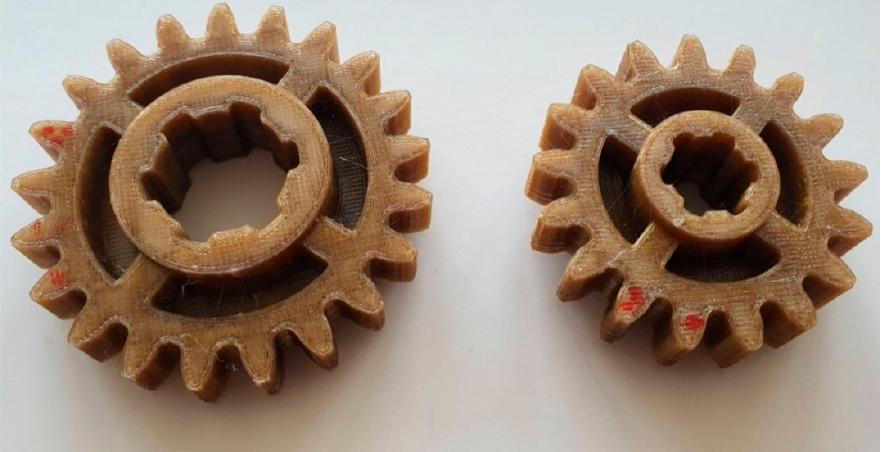
Figure 3. Gears manufactured using the FFF technique from PEEK.